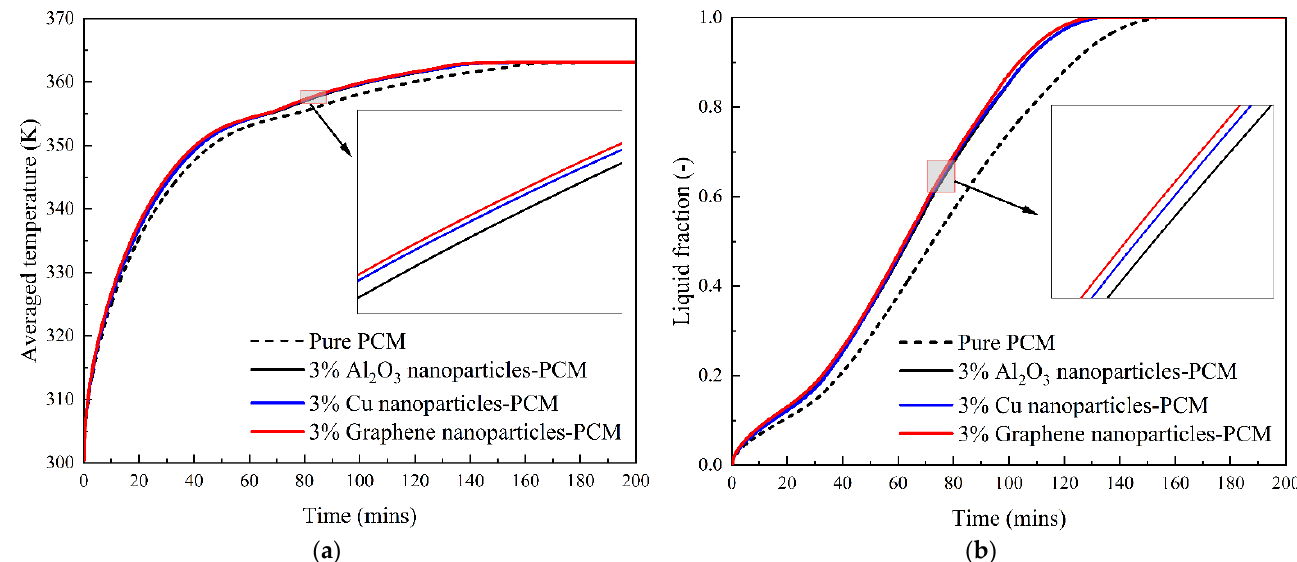
Figure 12. Effect of Al 2 O 3 nanoparticles on the PCM melting process. ( a ) Average temperature; ( b ) Liquid fraction.